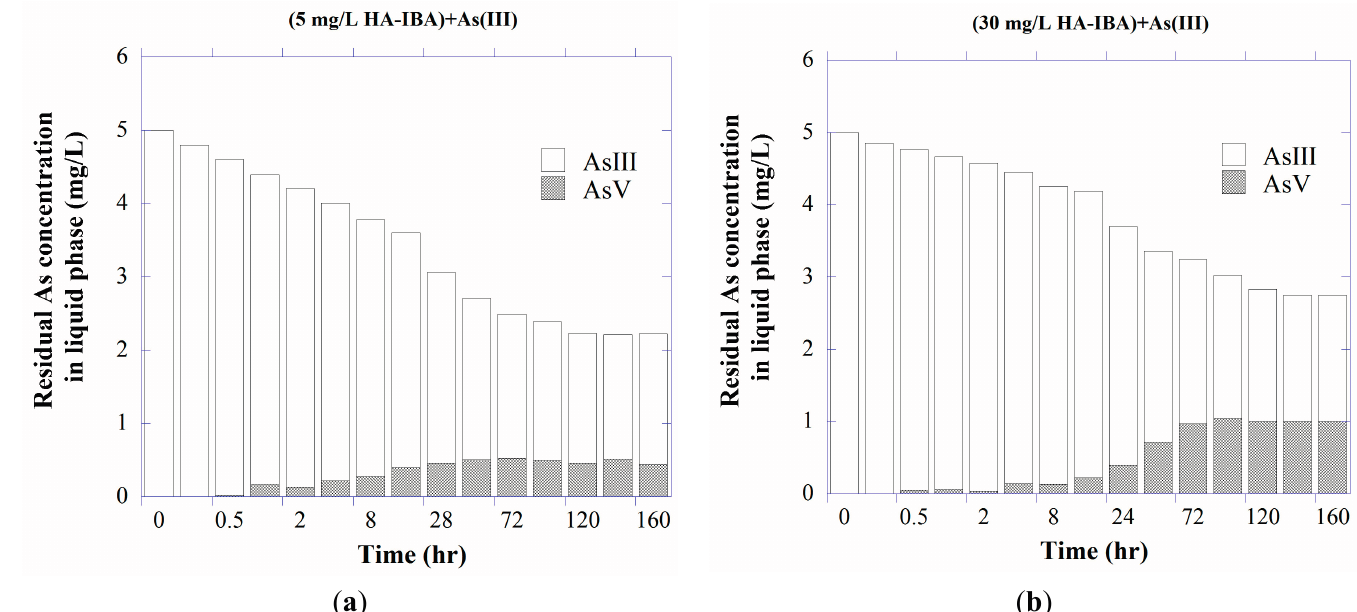
Figure 9. Redox transformation of ( a,b ) arsenite and ( c,d ) arsenate sorption onto HA-presorbed IBA for 168 h reaction. The initial concentration of As was 5 mg/L at pH 7.5 and symbols represent duplicate